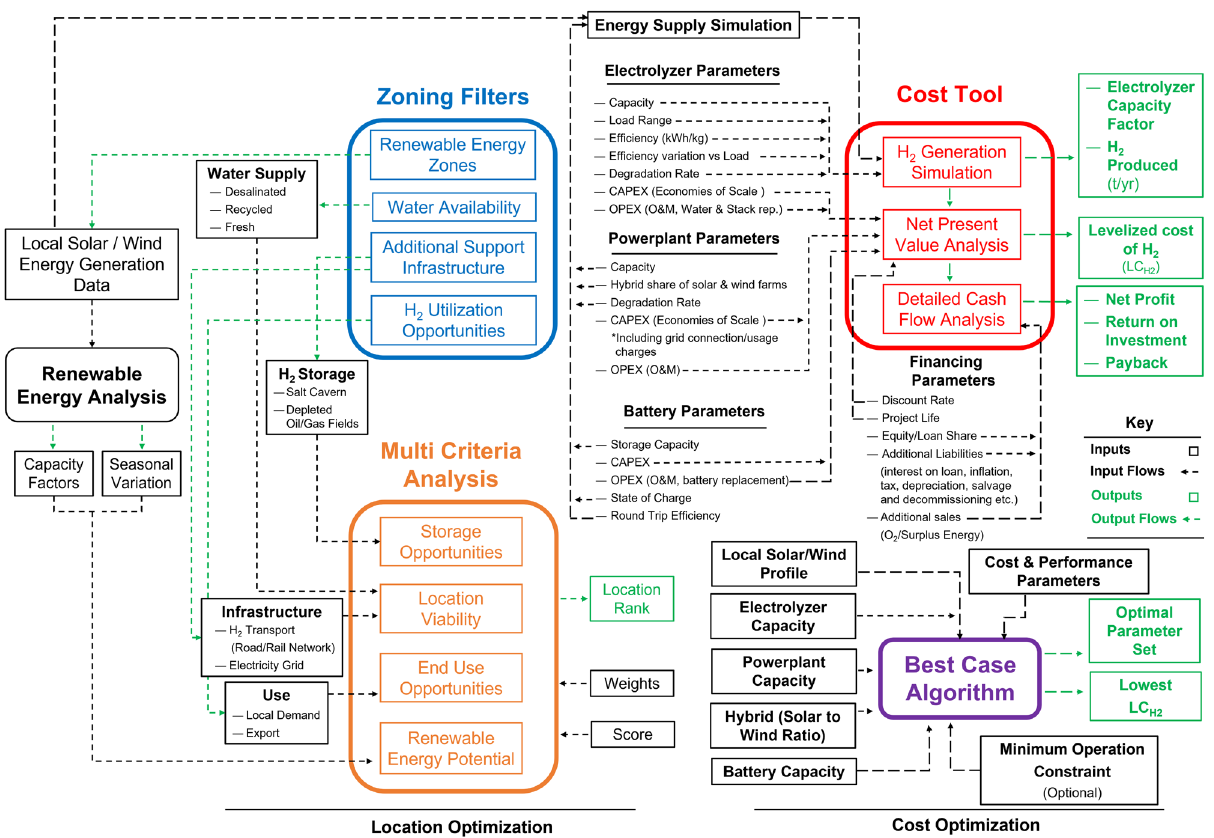
Fig. 1 Schematic representation of the proposed Framework. The framework is based on 4 interlinked tools/tiers; (i) First Tier — the zoning fi lters serve as guidelines for identifying potential sites for establishing H 2 Hubs, once the sites have been shortlisted each of the selected sites is assigned a rank based on a set of weights and score ranges de fi ned through the (ii) Second Tier — Multi Criteria Analysis (MCA Tool), and then the economics of hydrogen projects envisioned at these sites can be assessed using the (iii) Third Tier — HySupply Cost Tool and these economics can be optimized using the (iv) Fourth Tier — Best case Algorithm that establishes the capacity mixes/power rating of solar or wind or both and BESS capacity required to reach the lowest levelized cost of hydrogen generation (LC H2 ) or to achieve a speci fi c LC H2 target or operational capacity factor. Altogether these subtools make up the overall framework which is envisioned as a one stop solution for identifying and evaluating green hydrogen generation